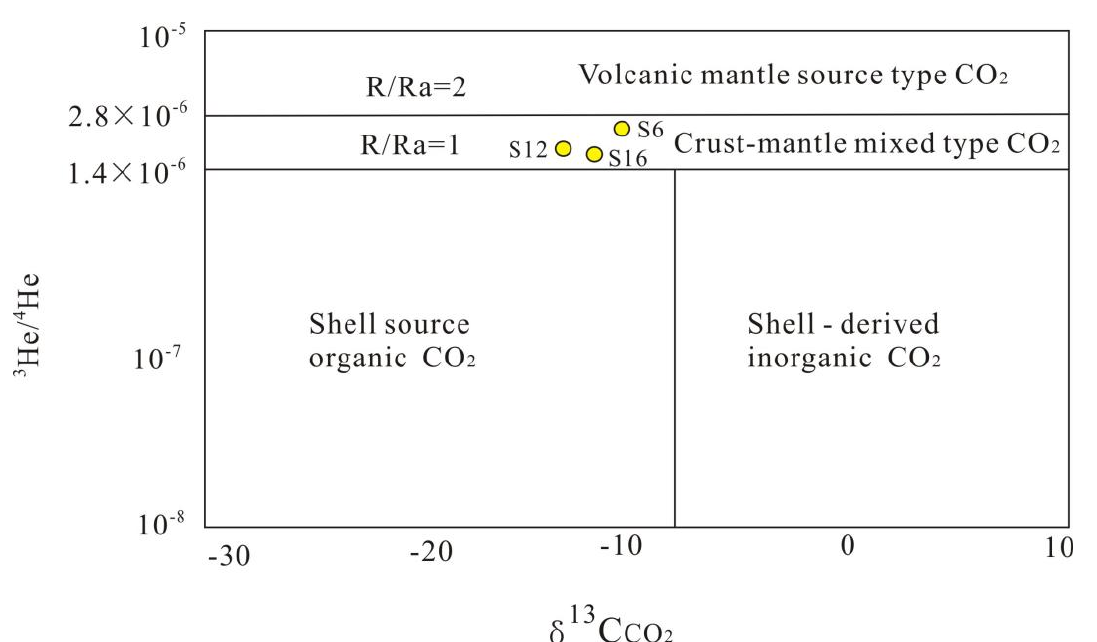
Figure 3. Helium isotope genetic discrimination map of Wuerxun depression of Hailar Basin.